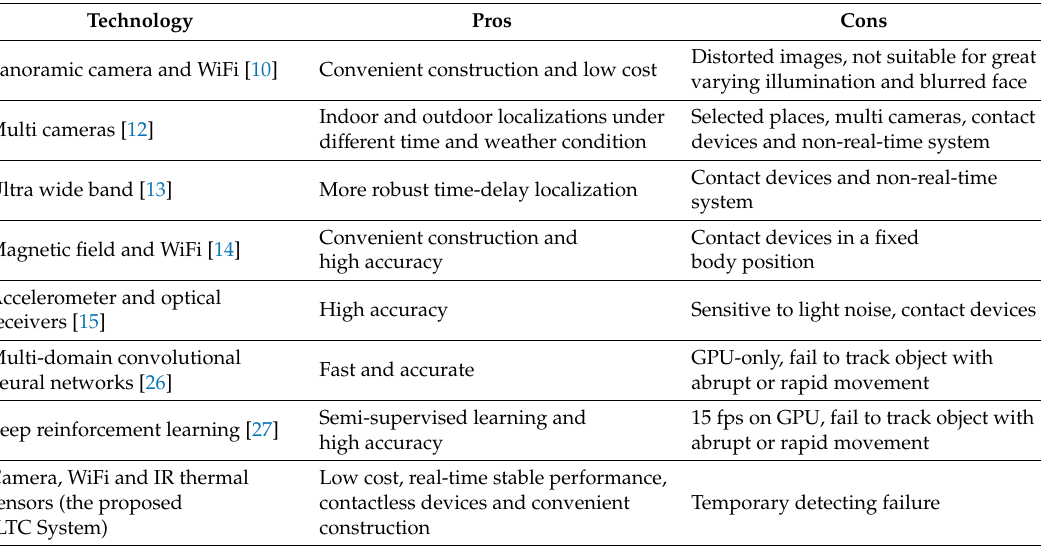
Table 3. Comparative Analysis among the existing localization and tracking